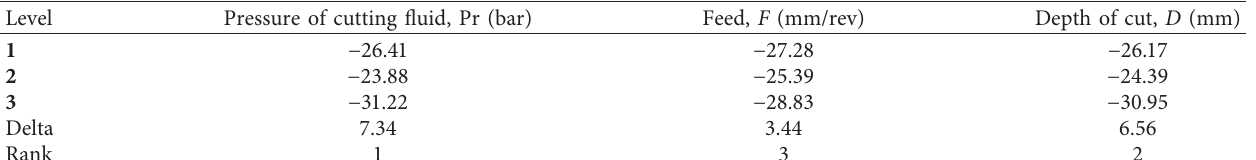
Table 7: Tool wear, surface roughness, and thrust force-based response ratios of signal to noise.